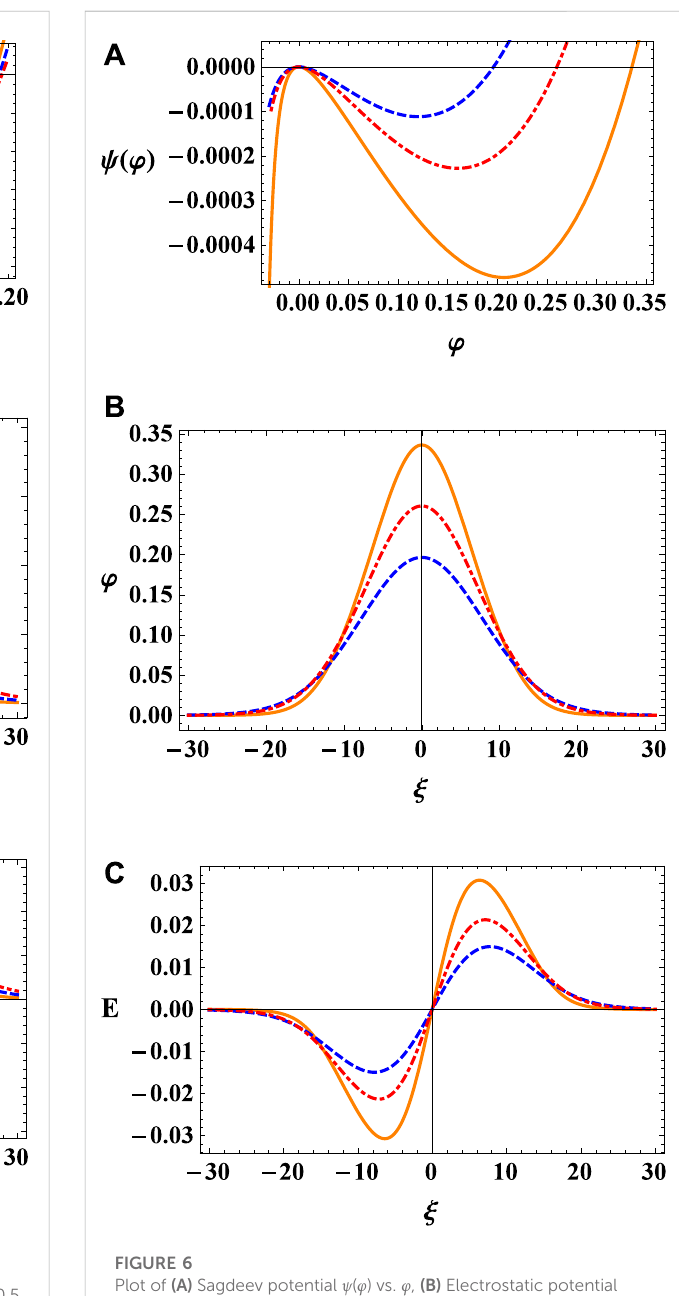
FIGURE 6 Plot of (A) Sagdeev potential ψ ( φ ) vs. φ , (B) Electrostatic potential φ and (C) Electric fi eld E for different pressure anisotropy cases p (cid:3) = p ⊥ = 0 (solid curve), p (cid:3) > p ⊥ (dashed curve) and p ⊥ > p (cid:3) (dot-dashed curve) with M = 0.85, Ω = 0.3, γ = 0.2, α = 0.80, and σ =